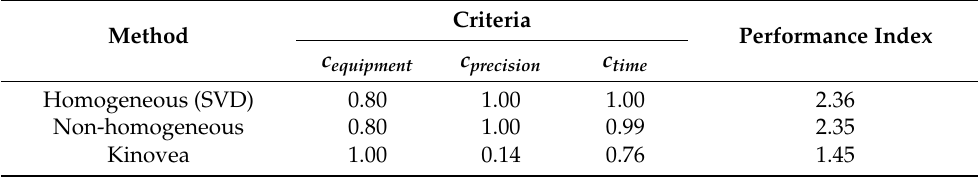
Table 10. Performance